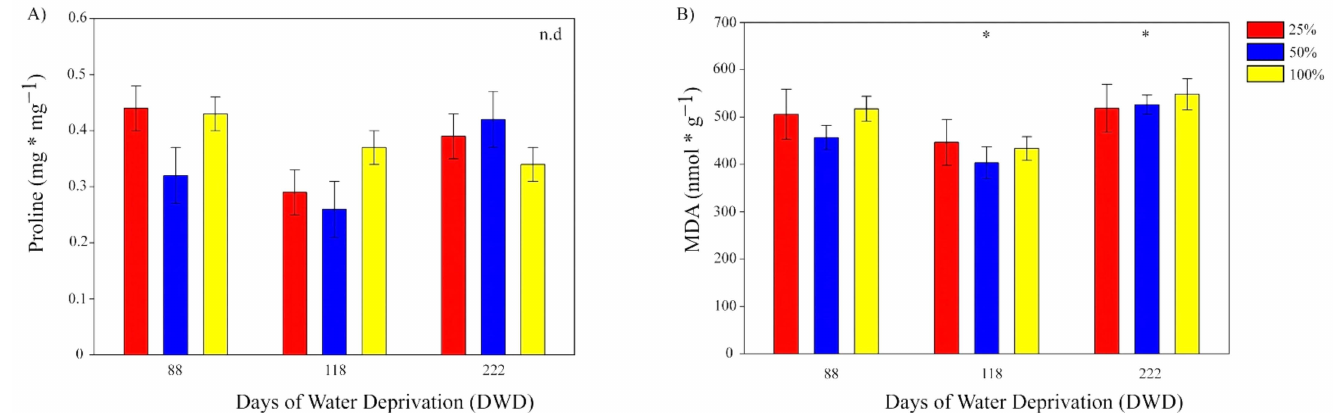
Figure 3. Bar chart showing the changes in ( A ). Proline content and ( B ). MDA content, in functions of the days with water deprivation (DWD). Bars correspond to the average value of each parameter, and the vertical lines indicate the standard error. Red, blue, and yellow colors represent the values for plants preconditioned at 25, 50, and 100% of field capacity of the soil (%FC), respectively. Asterisk indicates significant differences between DWD at p ≤ 0.05. n.d. denotes non-significant differences.